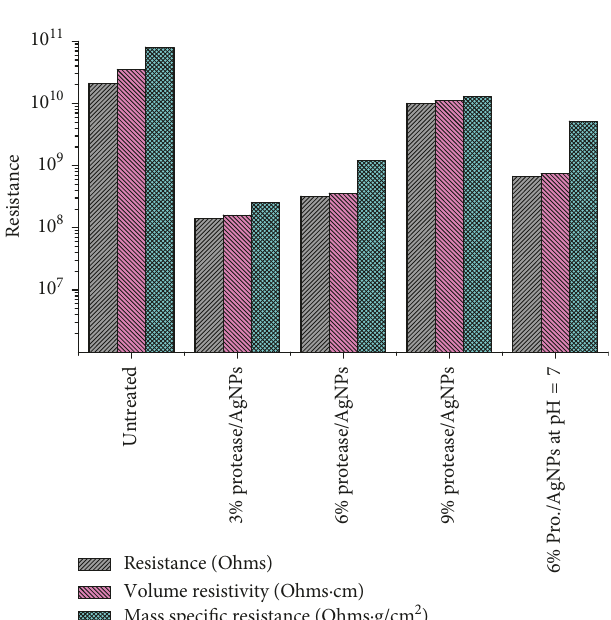
Figure 5: The volume resistivity of treated wool fibers.